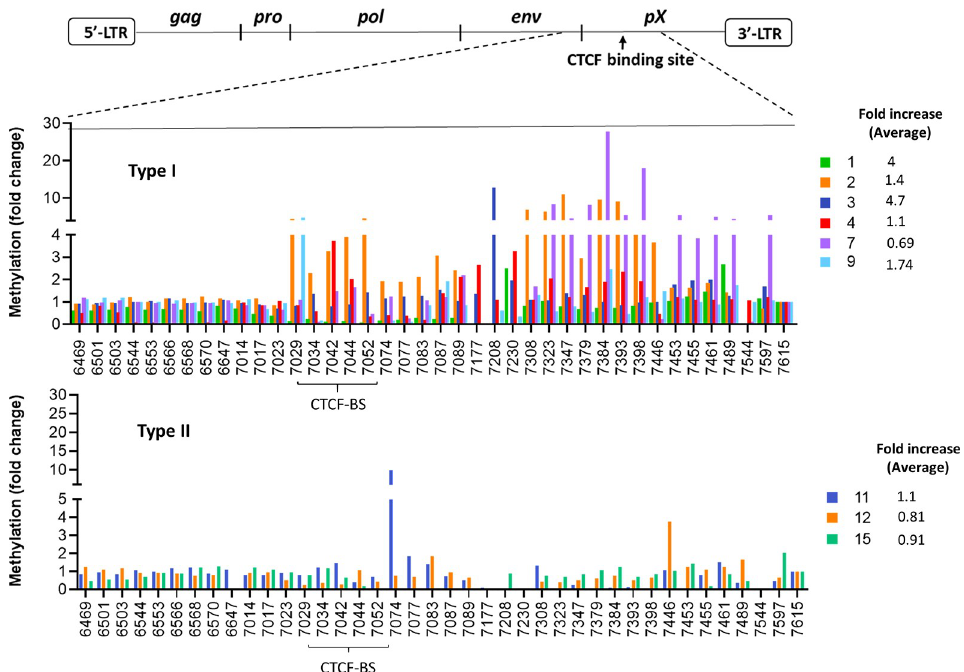
Fig 6. CTCF knock down by shRNA in clonal JET cell lines results in expansion of DNA methylation in the pX region of the provirus. DNA methylation of the HTLV-1 provirus is presented as fold change, CTCF vs control shRNA (Y-axis) at the indicated locations of the viral DNA (X-axis). Average fold increase is calculated from nt 7029 to 9615. The schematic diagram of the HTLV-1 provirus indicates the regions examined by bisulfite treatment and DNA sequencing as described in the Materials and Methods. Upper panel: Type I clonal cell lines. Lower panel: Type II clonal cell lines.